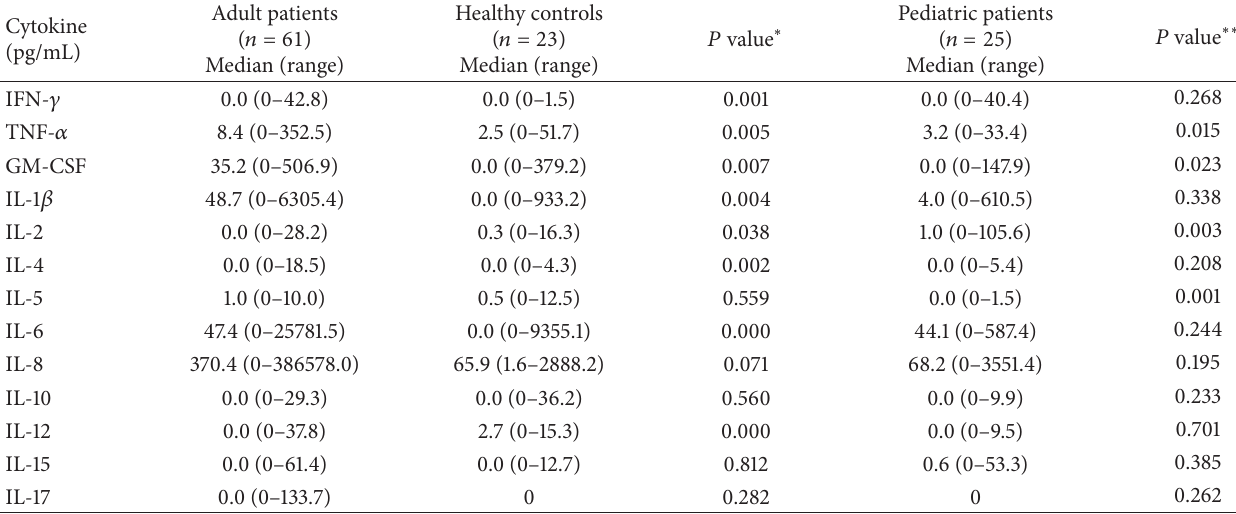
Table 2: Serum cytokine levels in the adult and paediatric patients with tuberculous lymphadenitis and healthy controls. Cytokine